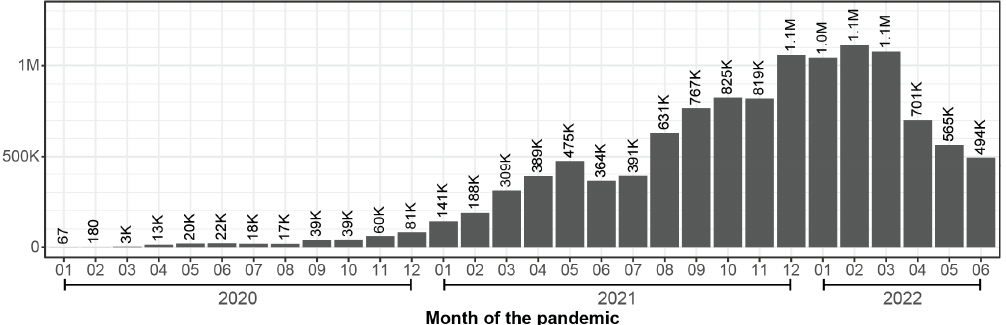
Figure 3. SARS-CoV-2 genomic sequences submitted to the GISAID data repository between Janu-